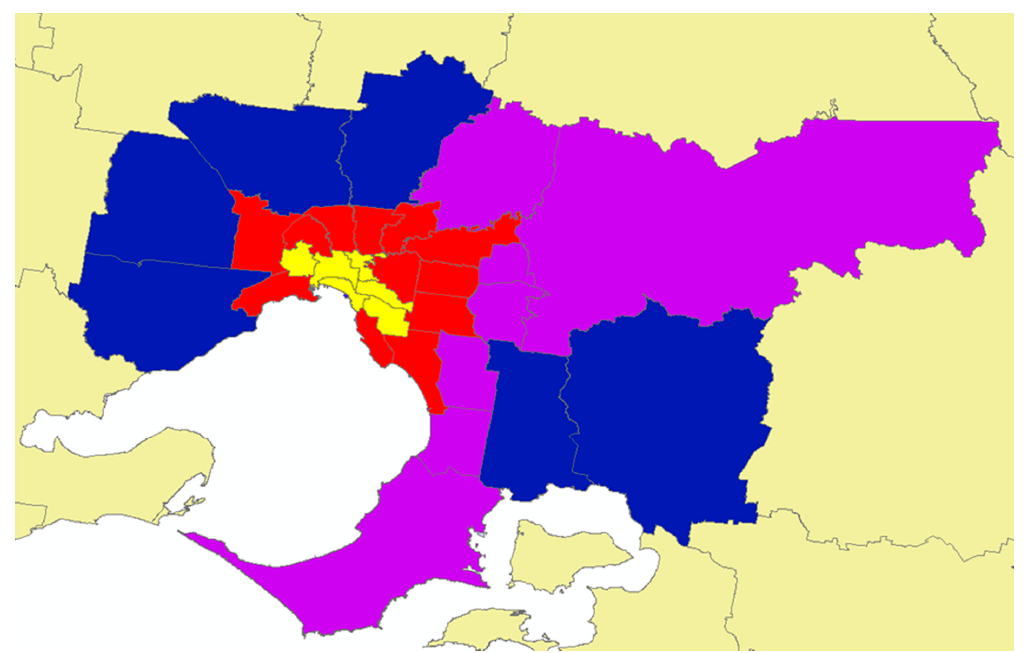
Figure 1. Local government areas classified by ring-like placement around Melbourne’s Central Business District (LGA-Rings). Local Government Areas: Yellow = Inner Ring; Red = Middle Ring; Purple = Outer Ring; Blue = Growth Areas.